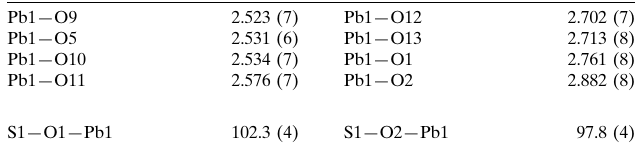
Selected geometric parameters (A˚ , (cid:2) ).